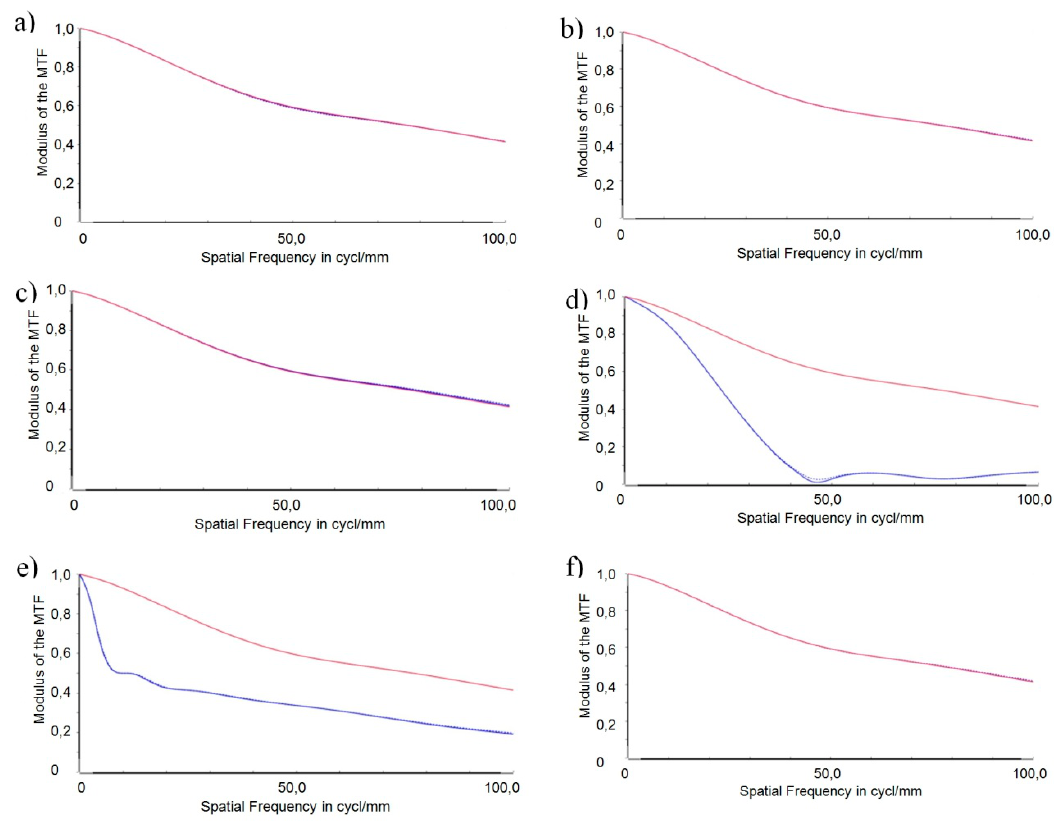
Figure 12. MTFs for the different types of position tolerances identified (blue) in comparison to the reference (red). ( a ) Decentration in x ; ( b ) Decentration in y ; ( c ) Decentration in z ; ( d ) Lateral position error; ( e ) Wedge error; ( f ) Orientation error.